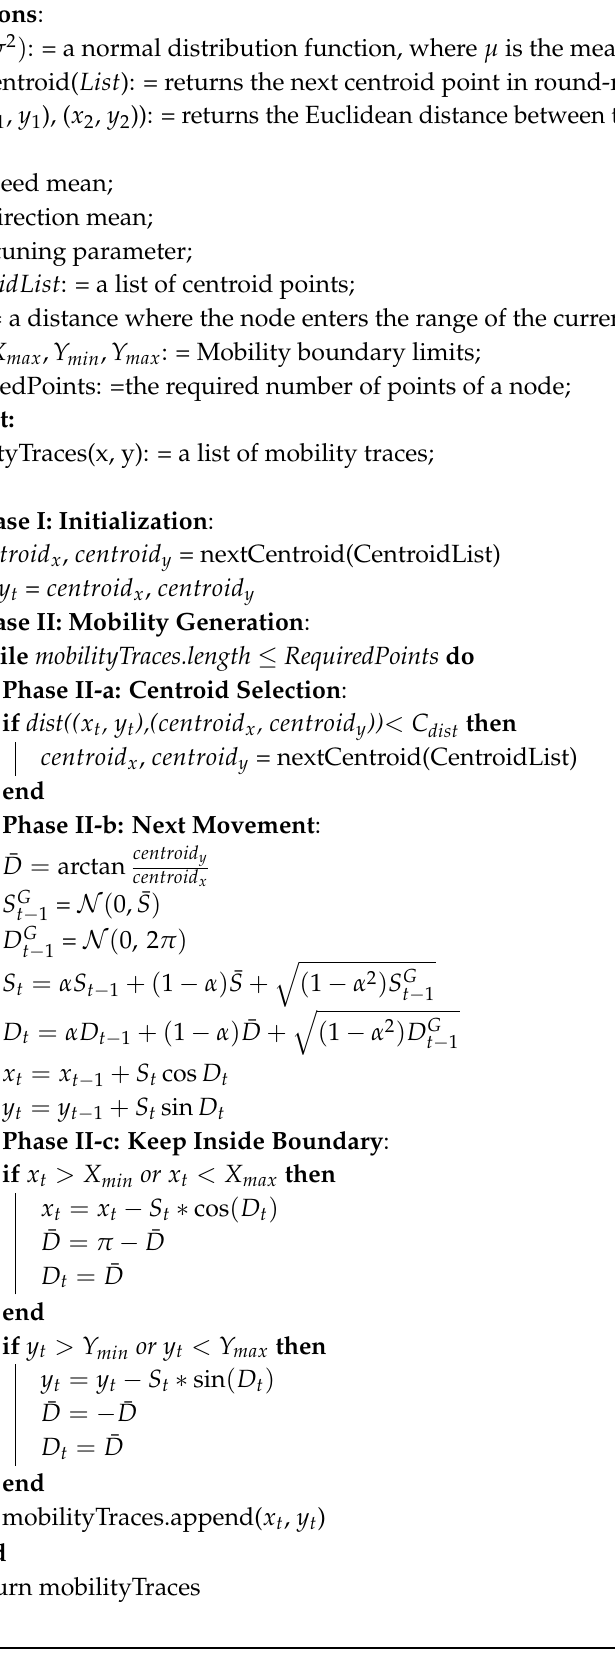
Algorithm 1: Recurrent self-similar gauss–markov mobility model. Functions